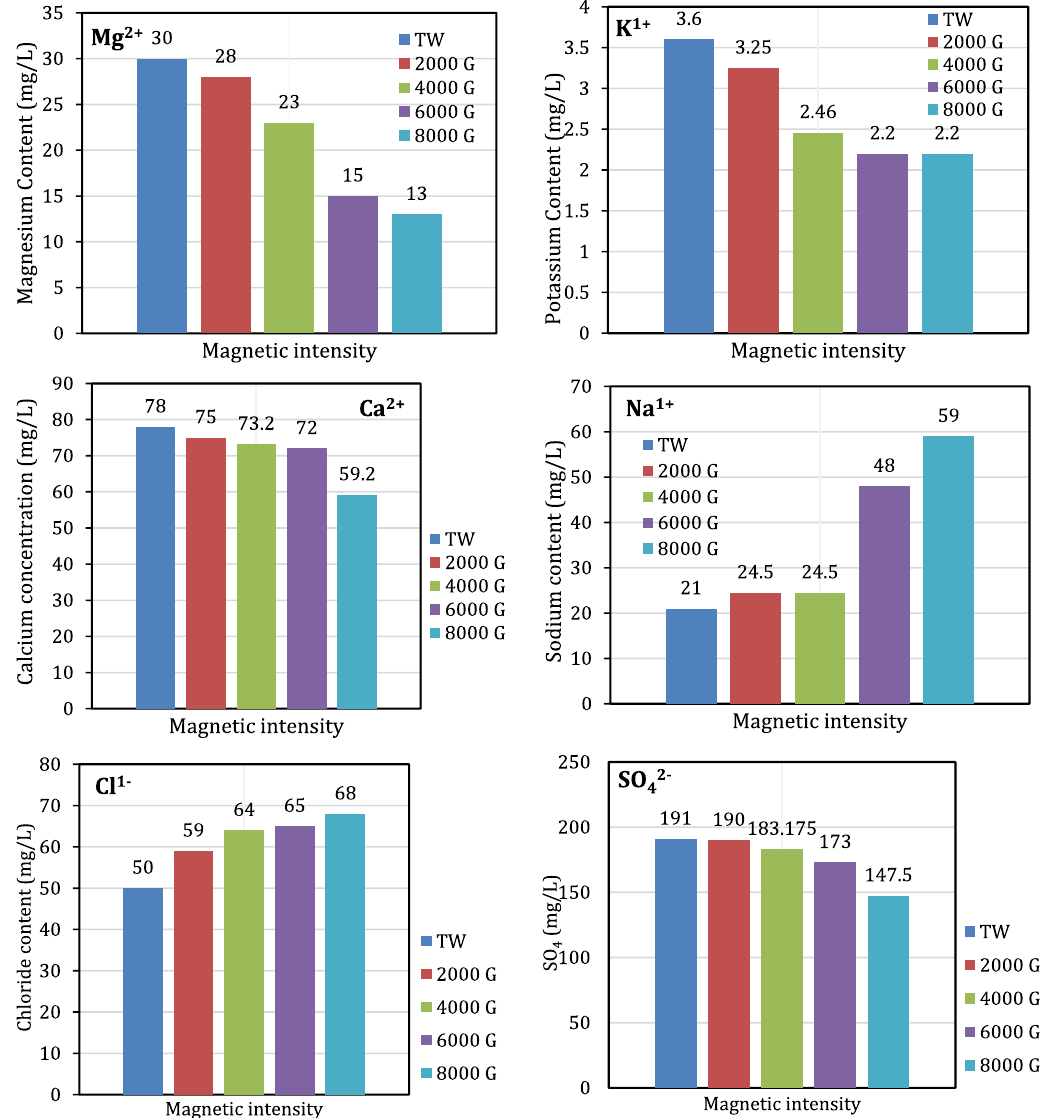
Figure 5: Variation in SO 4 , anions, and cations with the increase in MF